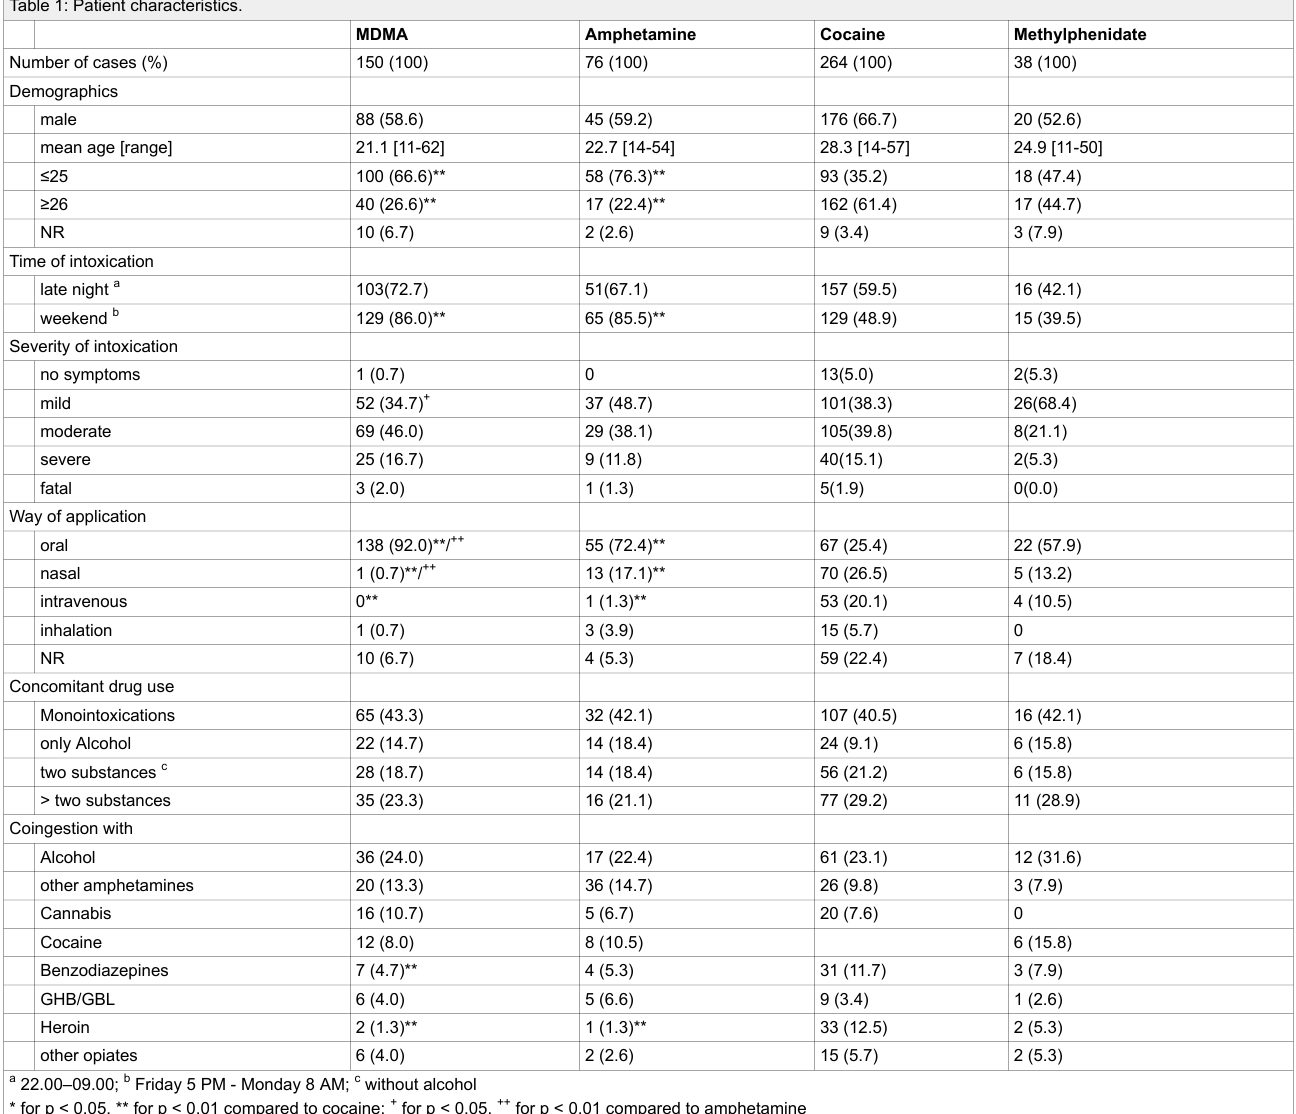
Table 1: Patient